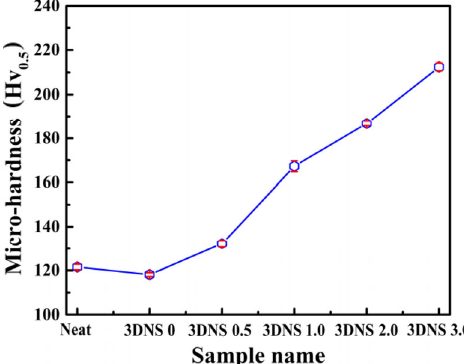
Fig. 6 Microhardness of epoxy resin and epoxy–Ti 3 C 2 3DNS composites.